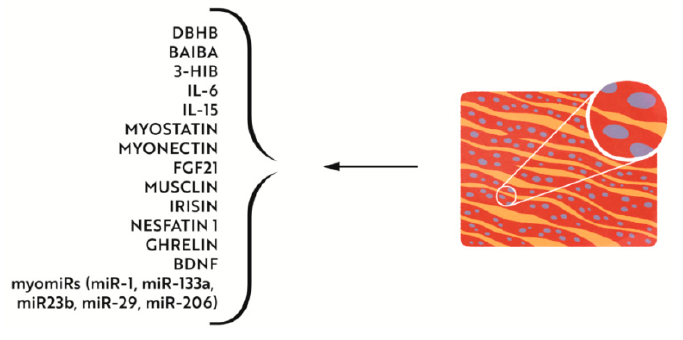
Figure 3. “Myocrinology”—muscle tissue as an endocrine organ.